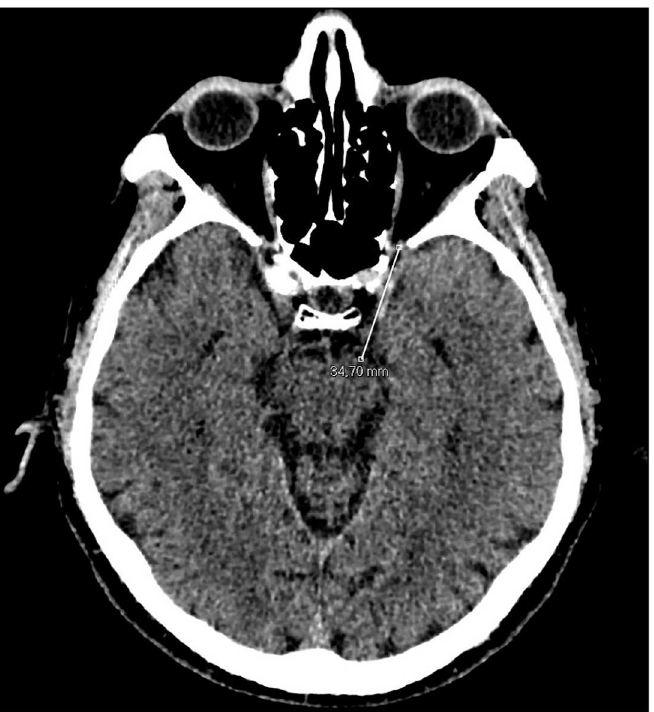
Fig 2. Measurements of the distances using linear system on axial CT scan. The distance between the superior orbital fissure and the substantia nigra (D-SOF-S).